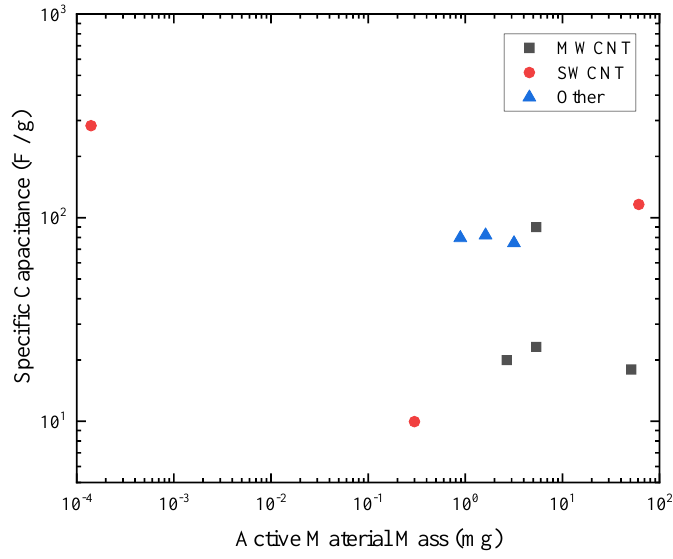
Figure 11. Relationship between specific capacitance and the mass of active material per electrode (either directly measured or estimated based on other measurements) from previous investigations of carbon-based supercapacitor electrodes. Data taken from references: [50,71,93–100]